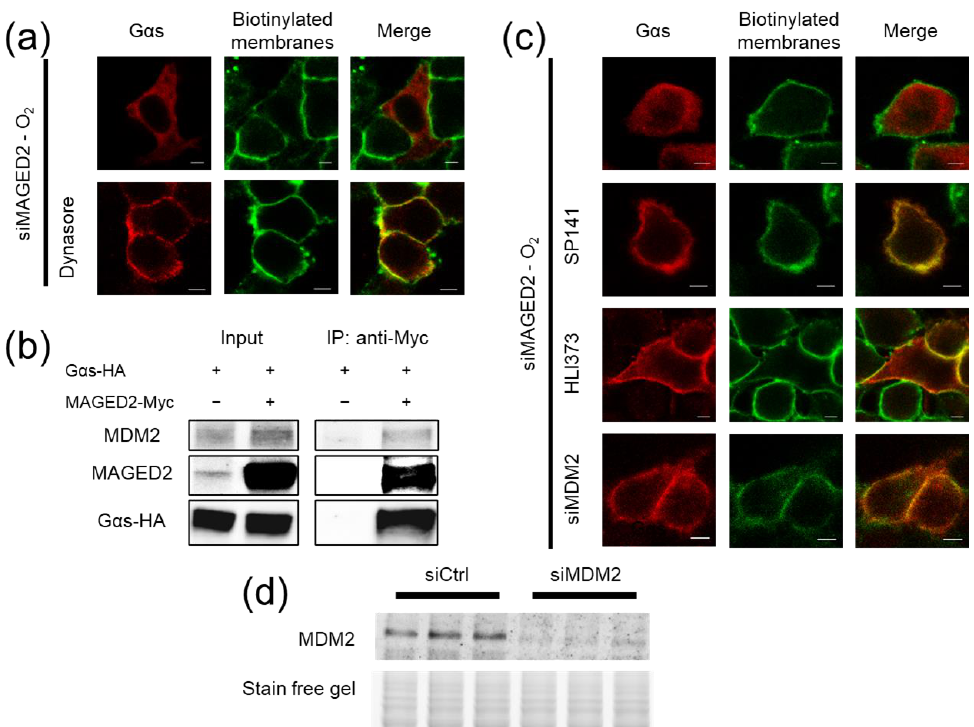
Figure 4. MAGED2 prevents MDM2-mediated internalization of Gas under hypoxia. ( a ) HeLa cells were co-transfected with G α s-HA construct and MAGED2 siRNA. Forty-eight hours post-transfection, cells were treated with physical hypoxia overnight in the presence or absence of an endocytosis inhibitor, Dynasore 50 µ M, as indicated. The stained specimens were evaluated by ApoTome microscopy. Scale bars, 5 µ m. ( b ) HeLa cells transiently transfected with a G α s-HA construct alone or in combination with a MAGED2-Myc construct were immunoprecipitated (IP) with anti-Myc antibodies. A total of 5% of total cell lysate was loaded for comparison. Co-immunoprecipitated G α s, MAGED2, and MDM2 proteins were detected by immunoblotting using anti-MAGED2, anti-HA, and anti-MDM2 antibodies, respectively. ( c ) HeLa cells were co-transfected with G α s-HA construct and MAGED2 siRNA with or without MDM2 siRNA. Forty-eight hours post-transfection, cells were treated with physical hypoxia overnight in the presence or absence of MDM2 inhibitors, SP141 (1 µ M), or HLI373 (3 µ M) as indicated. The stained specimens were evaluated by ApoTome microscopy. Scale bars, 5 µ m. ( d ) Cells were transfected with control or MDM2 siRNA as indicated. In 24 h post-transfection, cells were lysed in RIPA buffer and cell lysates were separated by SDS-PAGE and probed by anti-MDM2